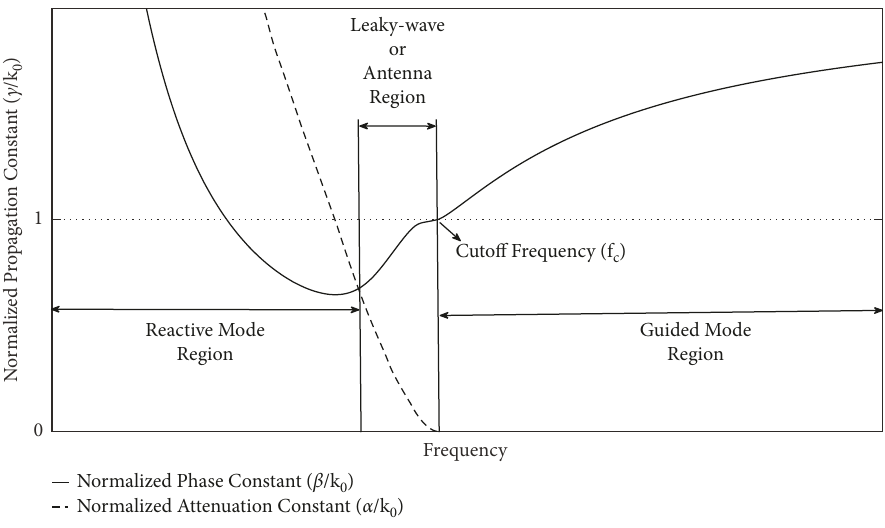
Figure 2: The general dispersion characteristic of open dielectric